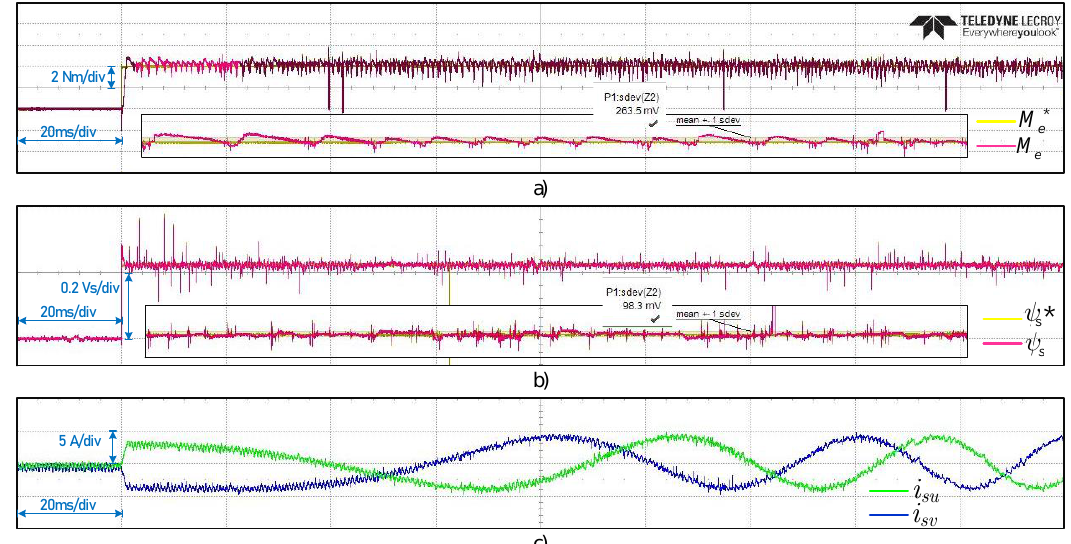
Figure 5. Steady state experimental results of the proposed deadbeat control. ( a ) Electromagnetic torque. ( b ) Stator flux. ( c ) Stator